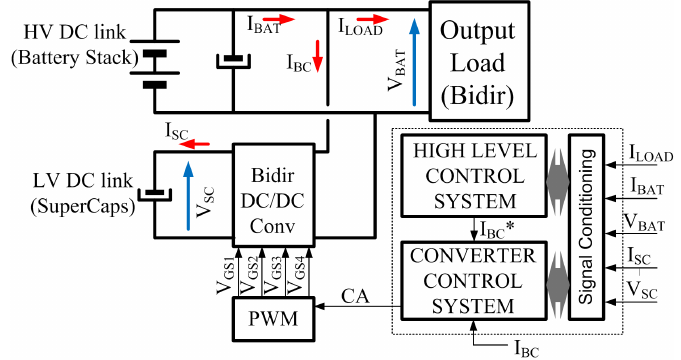
Figure 15. Control Strategy for the HBCS